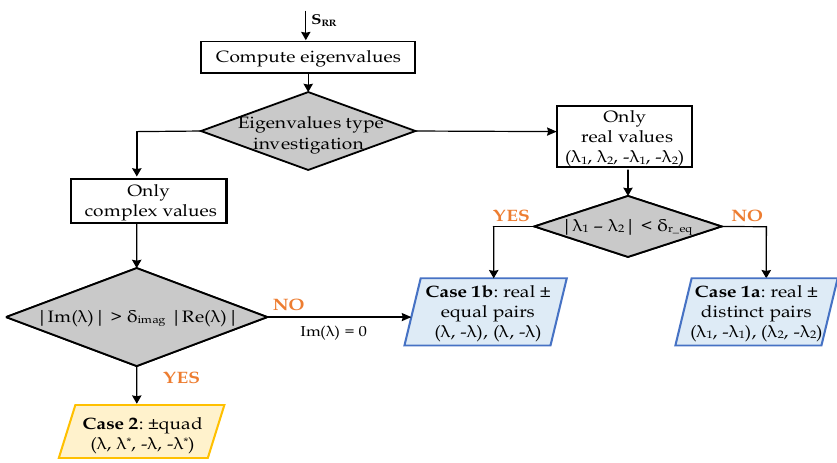
Figure 1. Flowchart for tolerance parameters